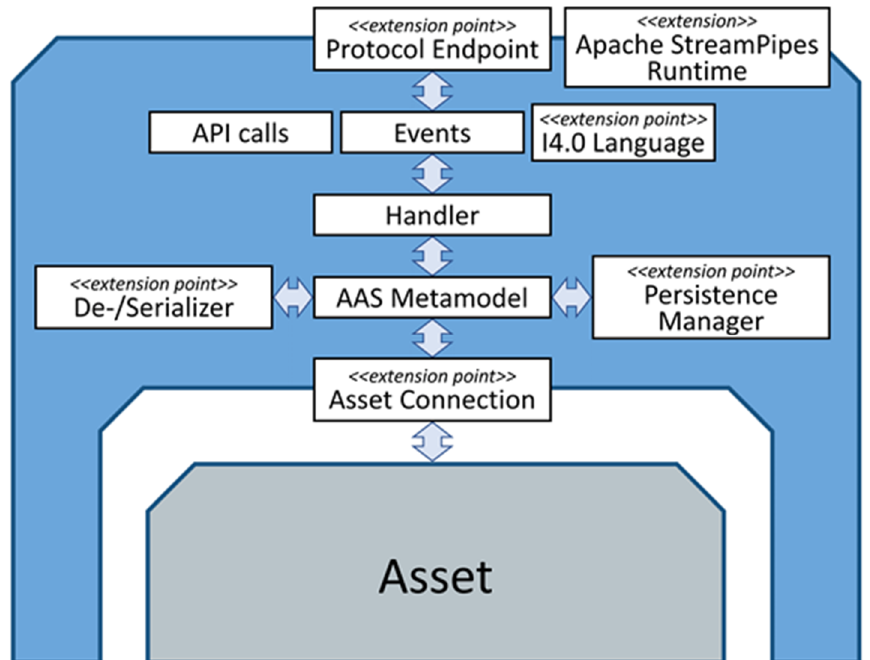
Figure 7. High-level schematic component diagram of the FA 3 ST service.